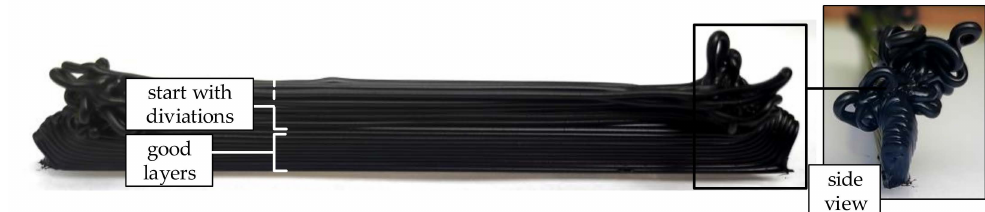
Figure 5. The printing result for stacking double strands. Seven to eight layers were laid well on top of each other until deviations occurred. The trigger of the deviations is probably caused by the reversal point, as the side view